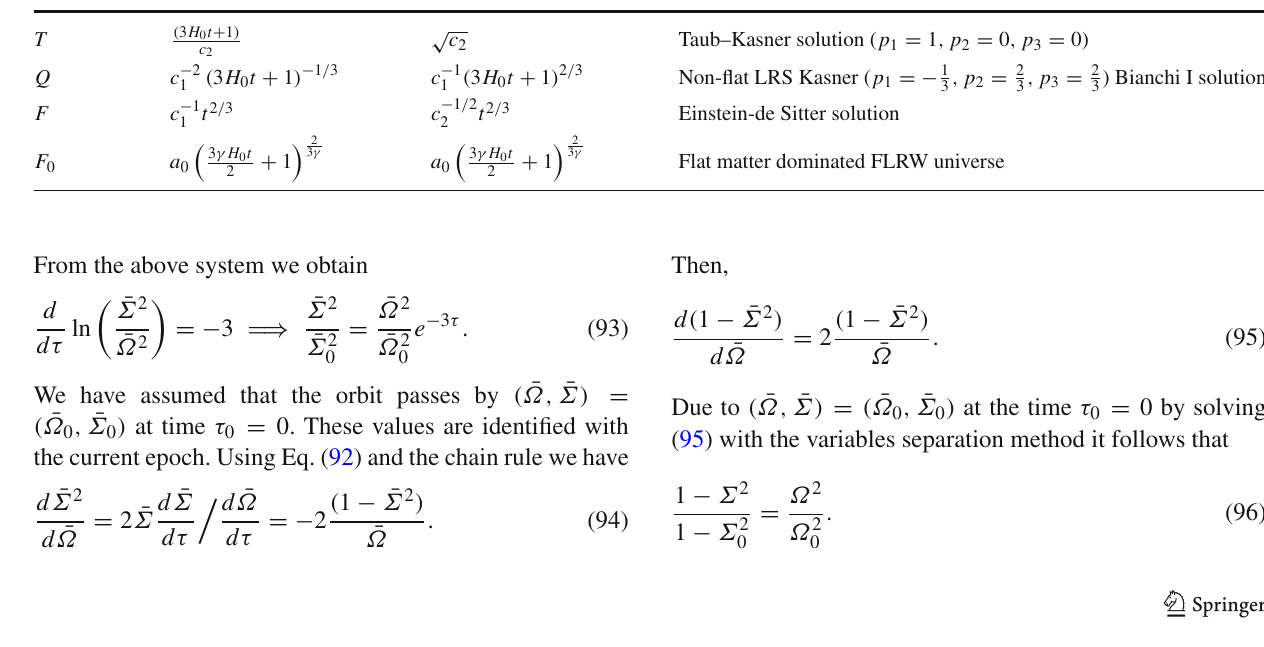
Table 1 Exact solutions associated with equilibrium points of the reduced averaged system (72a), (72b). A ( t ) and B ( t ) denote the scale factors of metric (32) and c 1 , c 2 ,(cid:15) 0 ∈ R +